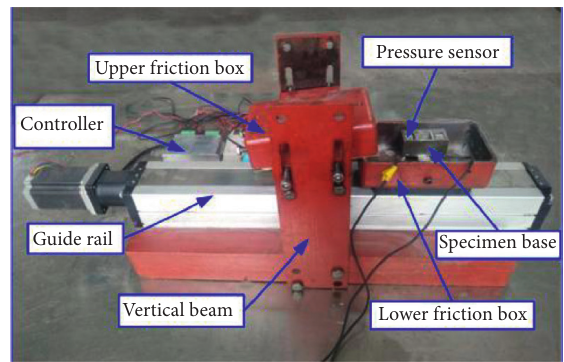
Figure 4: Photograph of reciprocating sliding friction test